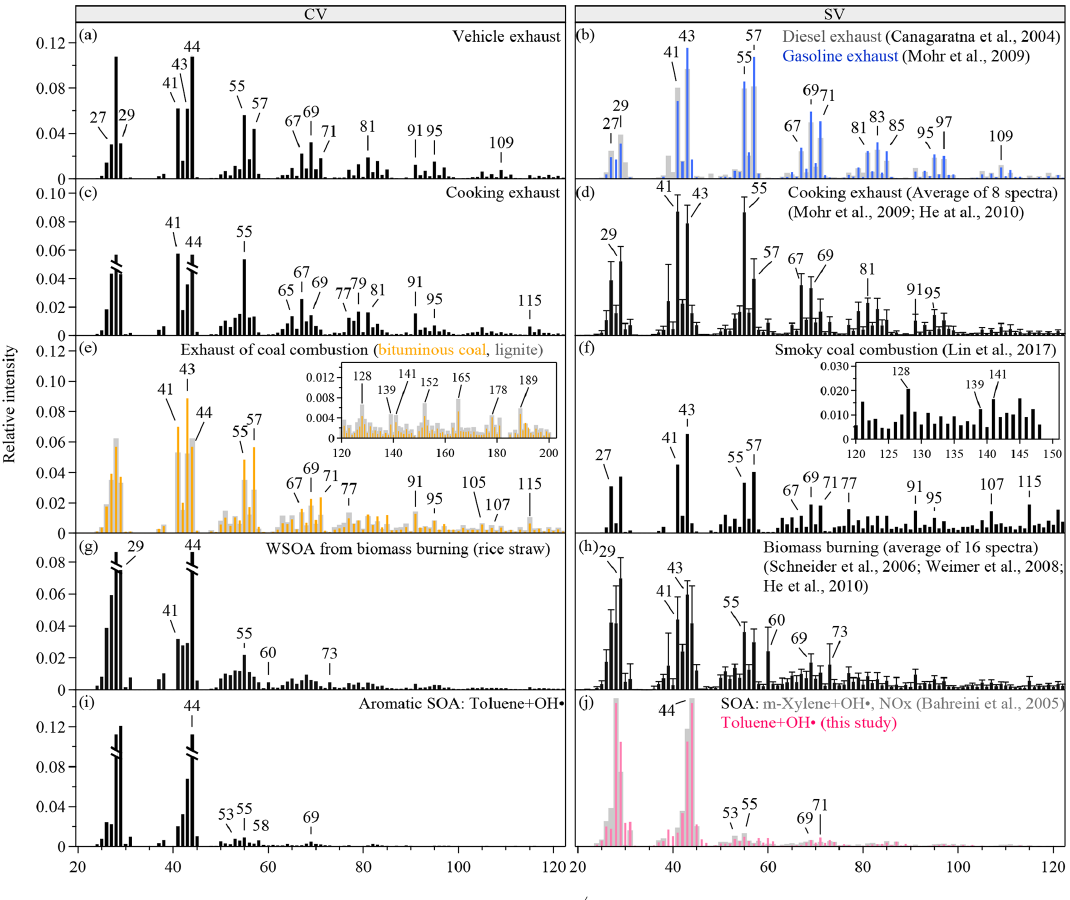
Figure 1. Mass spectra of OA produced from various anthropogenic sources. The CV spectra are obtained from the TOF-ACSM in this study. The SV spectra are taken from literature and the AMS spectral database (Ulbrich, I. M., Handschy, A., Lechner, M., and Jimenez, J. L., http://cires.colorado.edu/jimenez-group/AMSsd/, last access: 7 May 2019). The intensities of m/z 28 and 18 are calculated as 100% and 22.5% of the intensity of m/z 44 for all the spectra (Aiken et al., 2008). In panels (c) , (g) , and (i) , the relative intensities of m/z 28 and 44 are truncated to half of the original intensities. The error bars in panels (d) and (h) show 1 standard deviation of the relative intensities reported in the reference spectra and only the upper sides of the bars are shown. Mass spectra are shown for the m/z range of 20 to 120. The inserts in panels (e) – (f) show extended m/z ranges for the corresponding